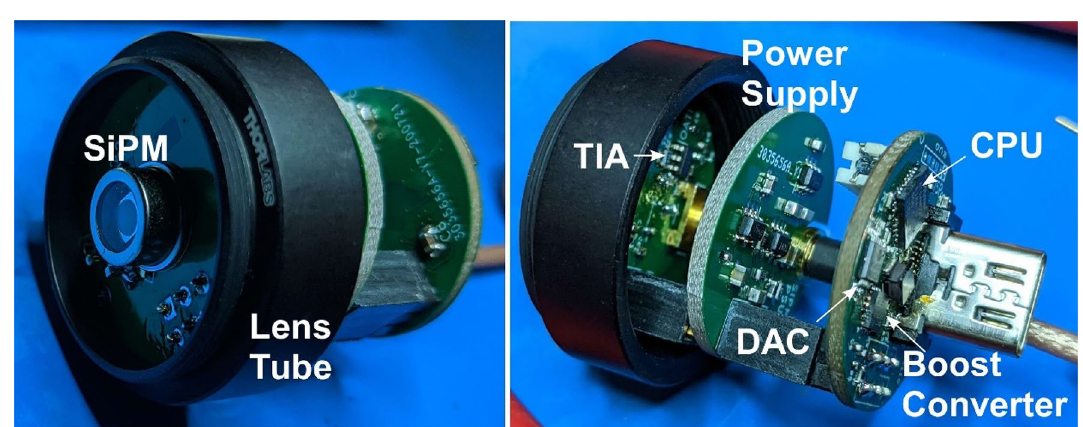
Figure 4. Assembled detector module in lens tube. The SiPM, current-domain PZC and TIA are on the front board, followed by a power supply board to generate the TIA voltage rails, and finally the boost converter and microcontroller on the last